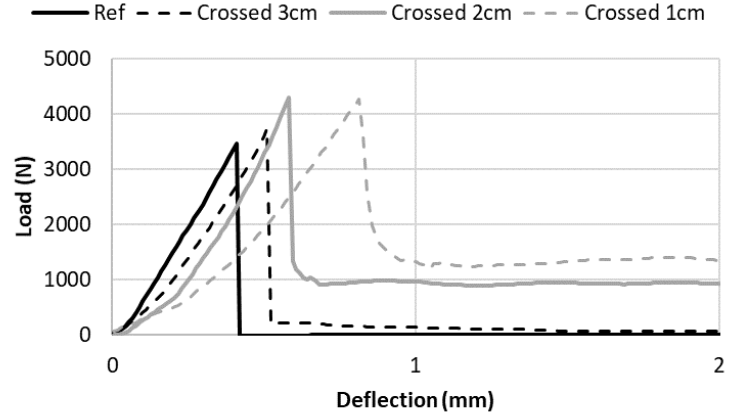
Figure 8. Effect of the density of nails (spacing between nails) on the post-peak behavior of the reinforced samples.